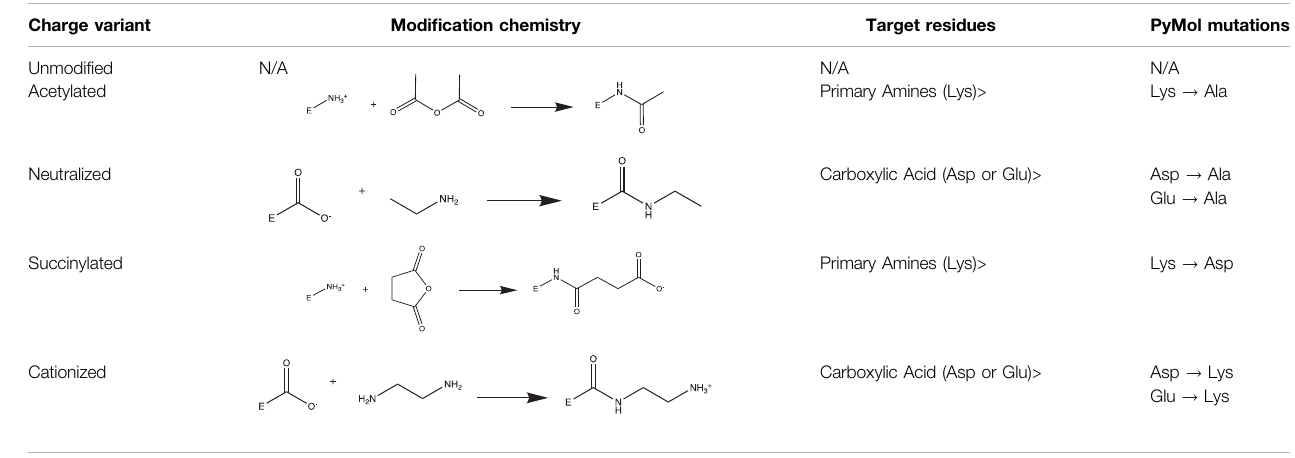
TABLE 1 | Summary of mutations to used mimic surface charge modi fi cations in